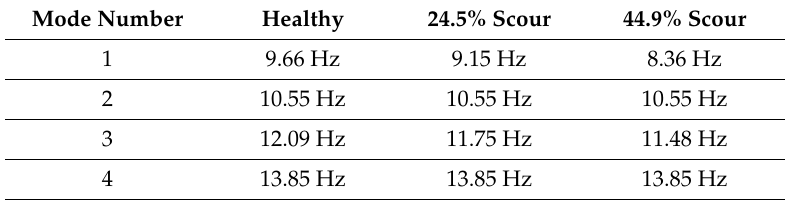
Table 3. System frequencies due to scour at Pier 2 (i.e., due to reduction in sti ff ness, k f,2